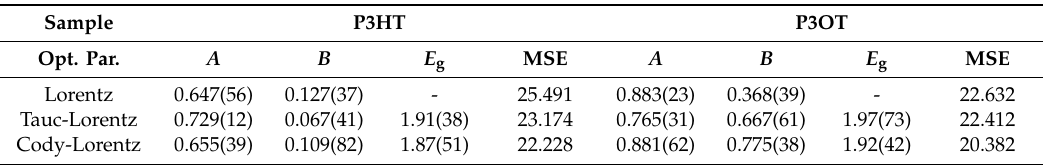
Table 1. Electronic parameters and mean square error (MSE) values of P3HT and P3OT determined from ellipsometric data with an estimated uncertainty.